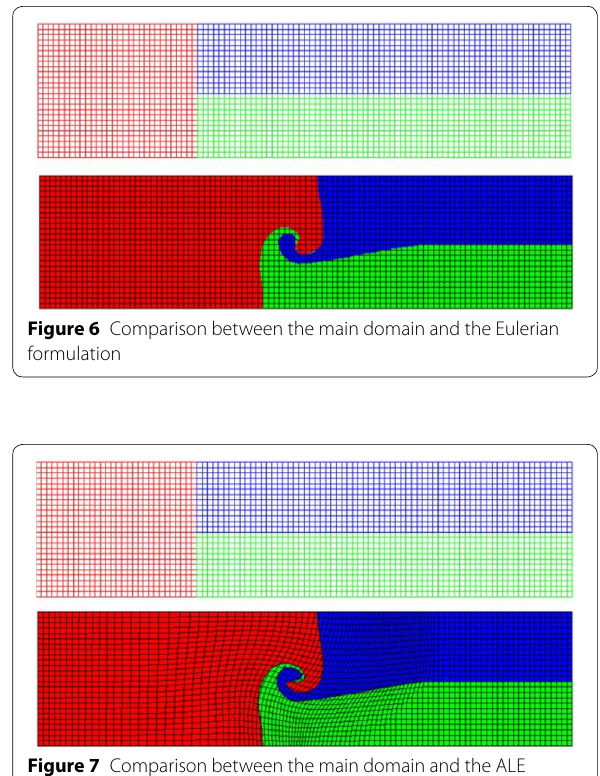
Figure 7 Comparison between the main domain and the